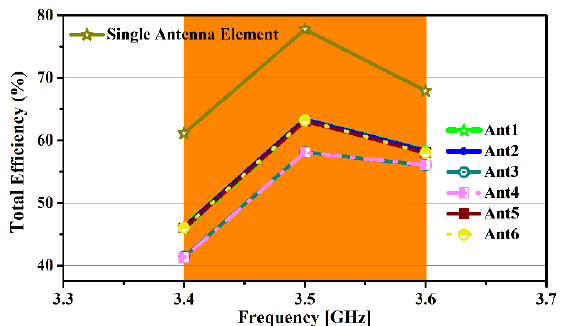
Figure 10. The total efficiency of the multiple antenna system free spaces (without the customer’s hand).